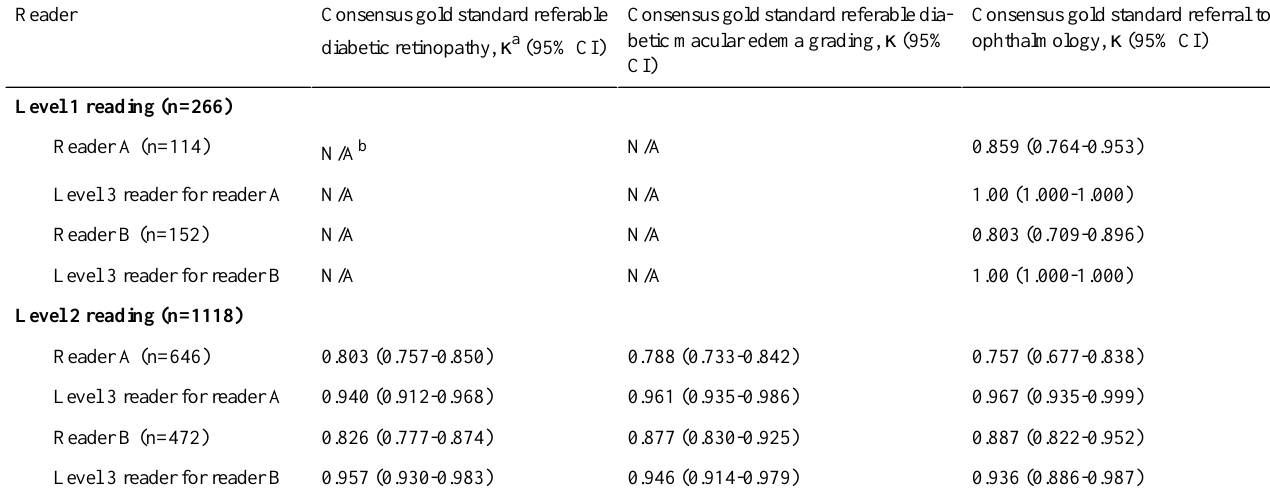
Table 2. Agreements of level 1, 2, and 3 readings for referable (>R2) diabetic retinopathy and diabetic macular edema (>M1) and referral to ophthalmology for all eyes versus the consensus gold standard (level 1 reading [n=266] and level 2 reading [n=1118]).